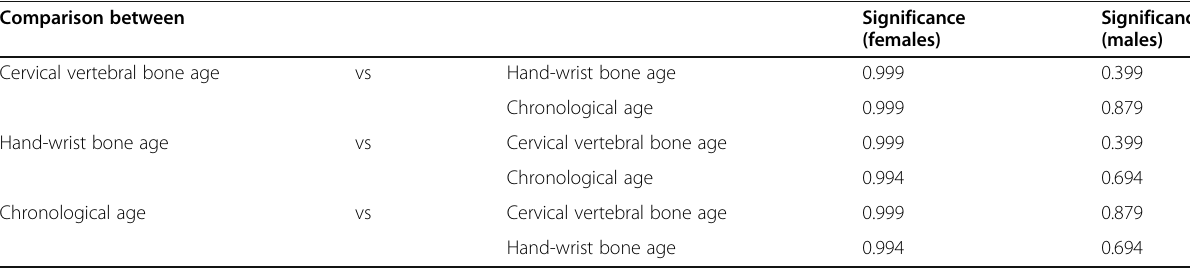
Significance (females) (males)